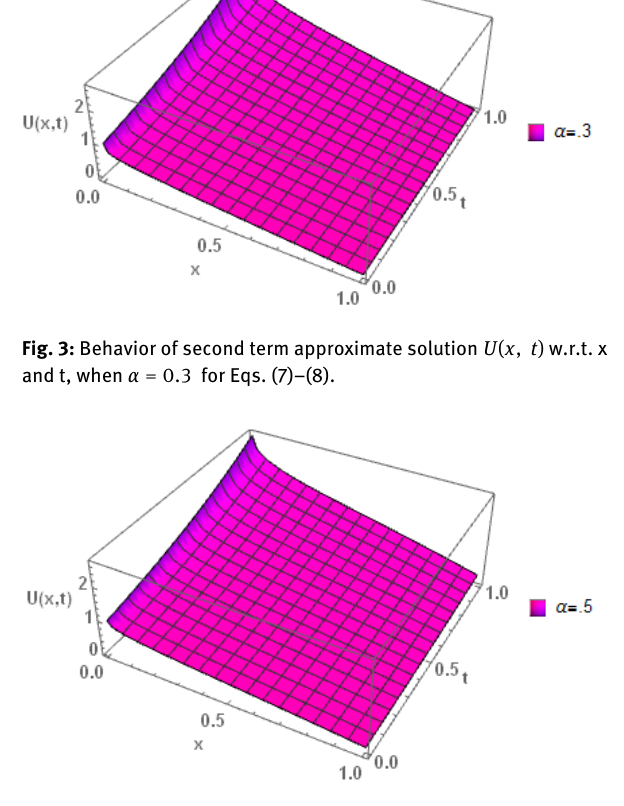
Fig. 4: Behavior of second term approximate solution U ( x , t ) w.r.t. x and t, when α = 0.5 for Eqs. (7)–(8).